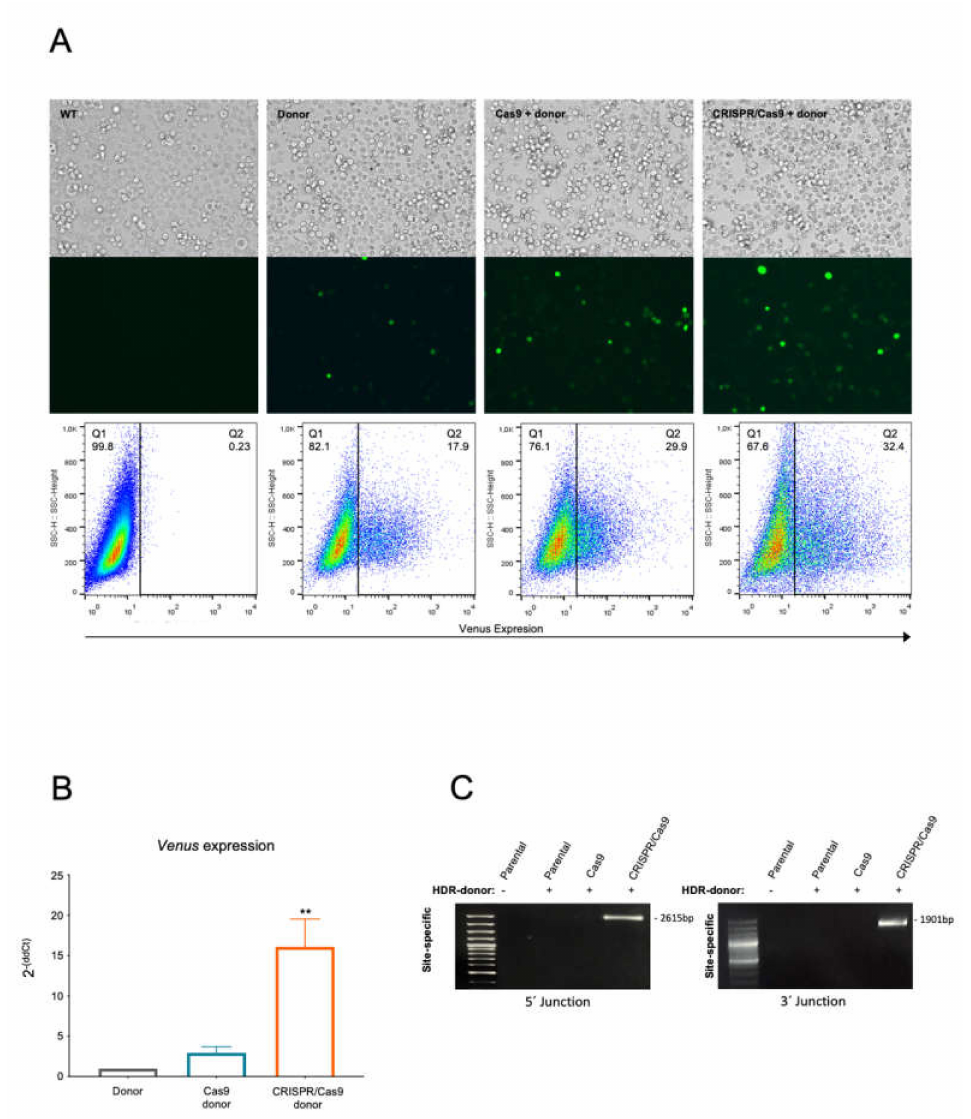
Figure 2. CRISPR-Trap system electroporation in K562 cells. ( A ) Venus expression K562 electro- porated with HDR donor (used as control) and CRISPR-Trap system (CRISPR/Cas9-HDR donor), and Venus-positive cell quantification by flow cytometry of each condition. ( B ) Venus expression quantification by real-time PCR. ( C ) Molecular characterization of the CRISPR-Trap system. 5 (cid:48) and 3 (cid:48) junction site-specific PCR amplification in cells electroporated with CRISPR-Trap system in 5 (cid:48) (oligos: Out5 (cid:48) F/VenusR) and 3 (cid:48) (oligos: VenusF/Out3 (cid:48) R junctions (2615 bp and 1901 bp, respectively). ** p <